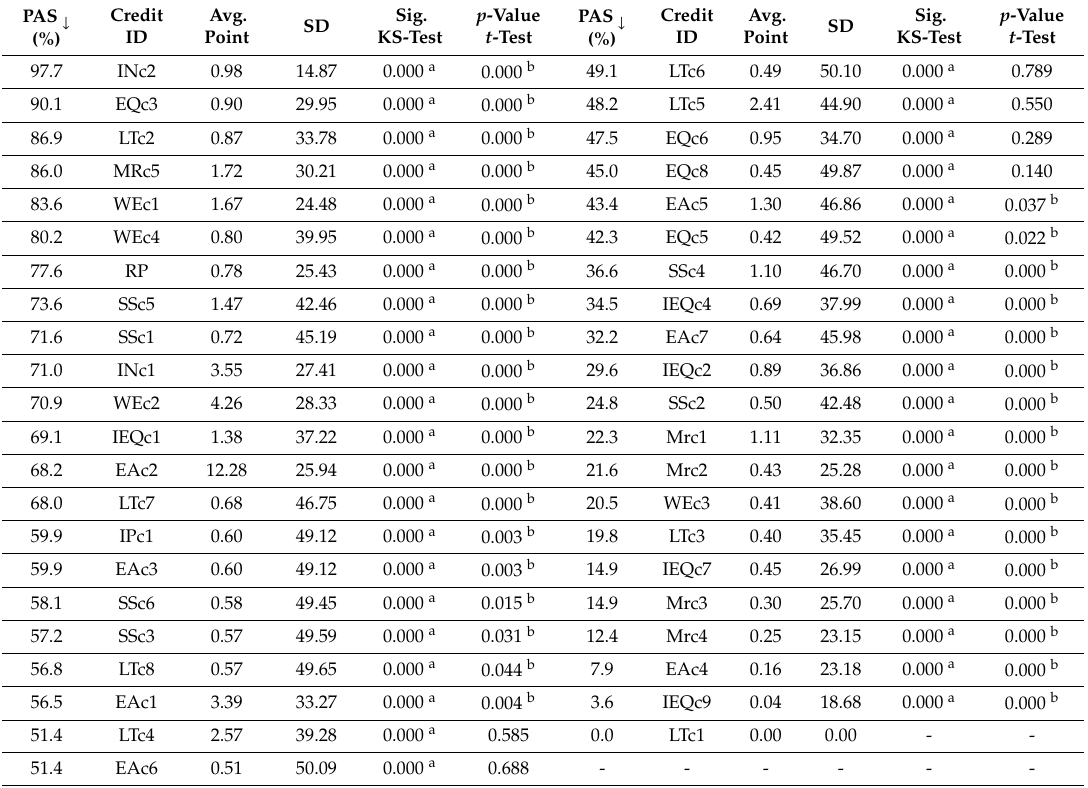
Table 2. Credit popularity ranking and the results for the Shapiro–Wilk normality and one-sample t